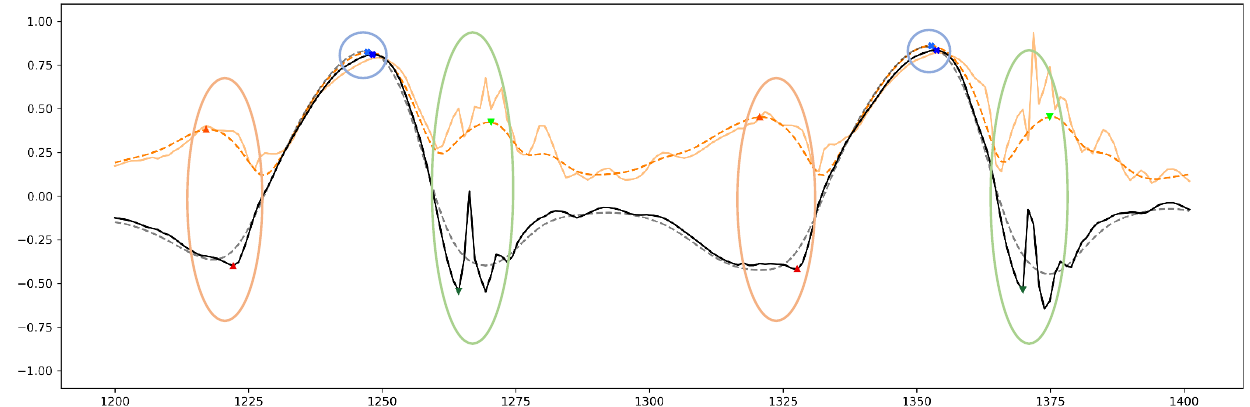
Figure 2. An example of the angular velocity signal used for labeling the gait phases. These signals are scaled from − 1 to 1. The black solid line represents Gyr_Z, the gray dashed line represents smoothed Gyr_Z, the solid orange line represents AngVelMag, and the dashed orange line represents smoothed AngVelMag. HS, MidS and TO are shown in dark red, dark blue and dark green markers on Gyr_Z based on the concept of [15] and FO, MidS and FC are highlighted with light red, light blue and light green markers on smoothed AngVelMag according to our approach for labeling gait phases.